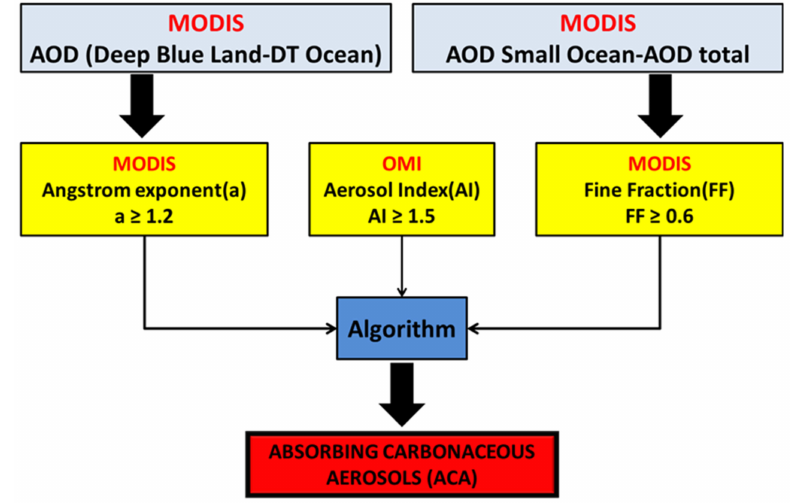
Figure 1. The satellite-based algorithm and methodology applied for the identification of absorbing carbonaceous aerosols